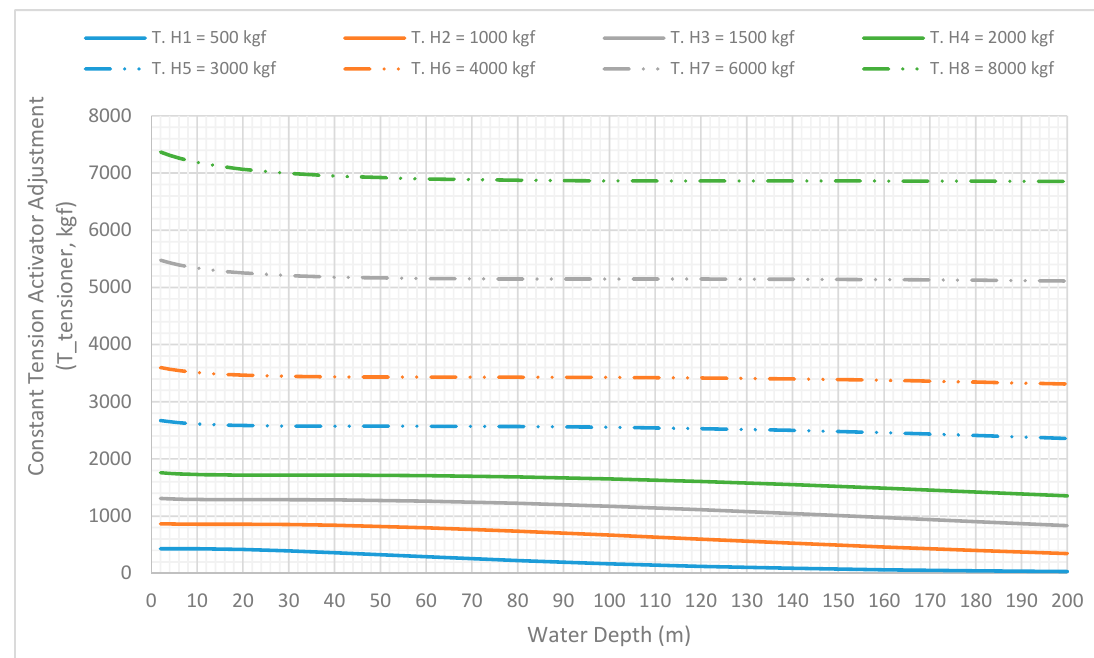
Figure 8. Constant tension activator adjustment (T_tensioner) using various bottom tension values (500 kgf–8000 kgf) and water depths (2 m–200 m).